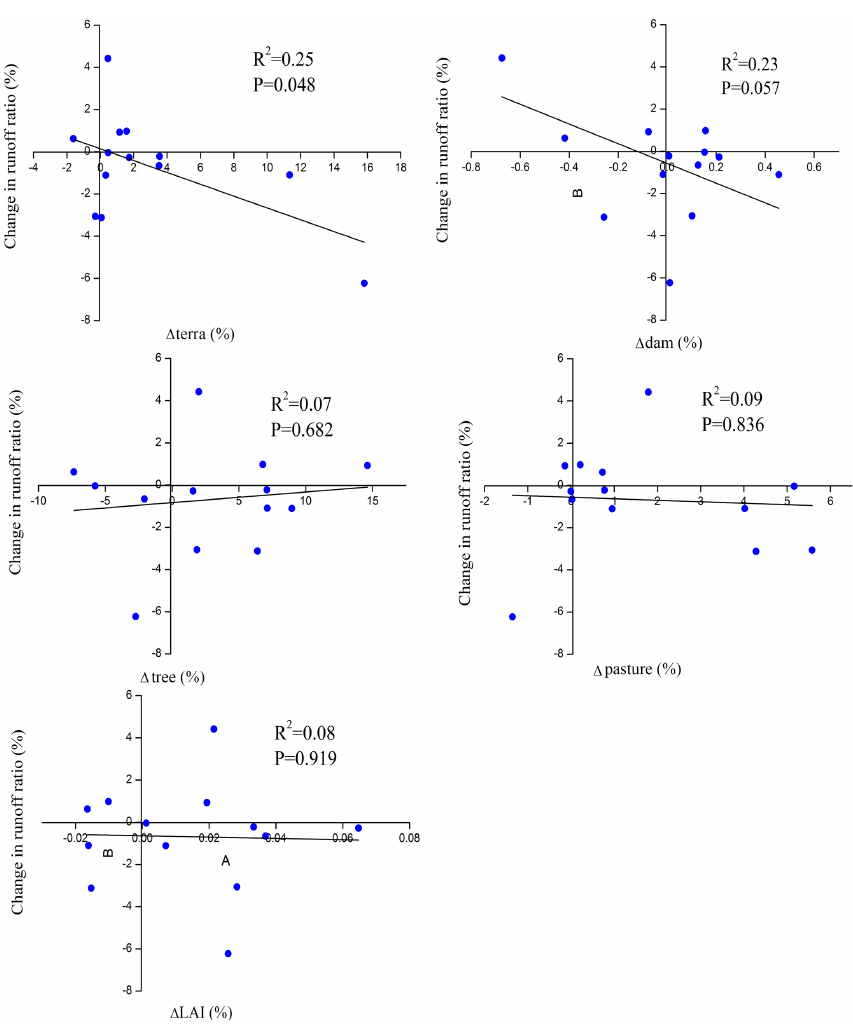
Figure 9. Anthropogenic factors of runoff ratio change in the 1980s vs. the 1990s (Terra, Dam, Tree and Pasture are the changes in the percentage area of terraces, check-dams, tree plantation and natural pastures, respectively. LAI is change in the GIMMS LAI for each catchment).